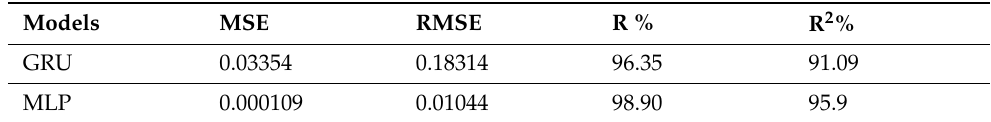
Table 3. Results of the GRU and MLP models from the testing